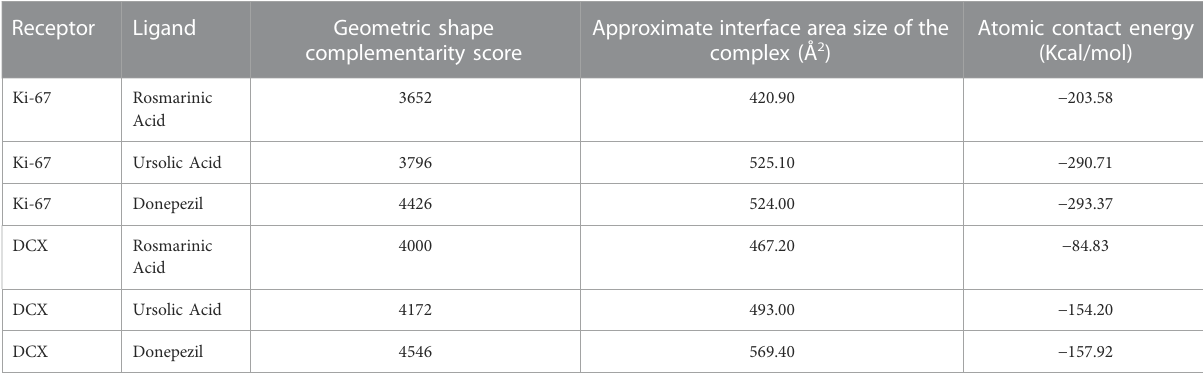
TABLE 1 Protein docking scores evaluated by Patchdock.